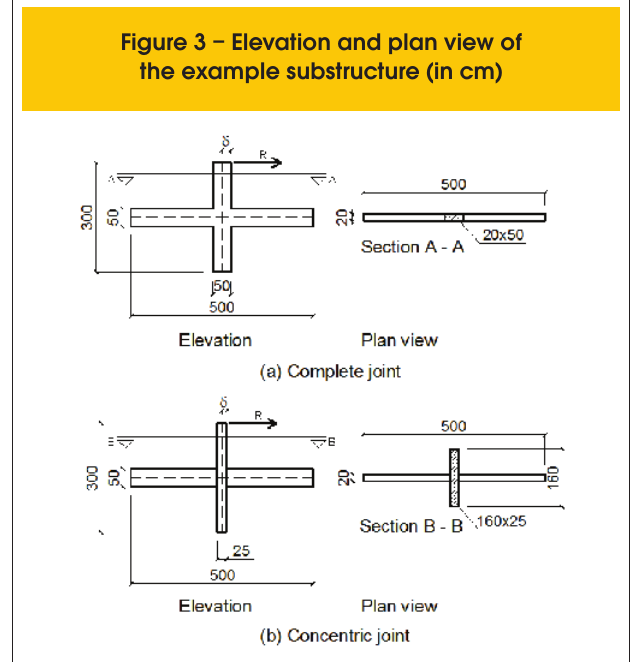
Figure 3 – Elevation and plan view of the example substructure (in cm)